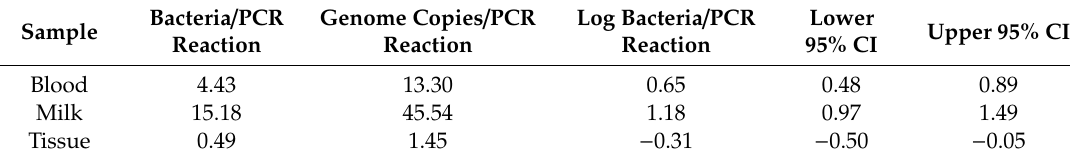
Table 5. Inter ‐ and intra ‐ assay reproducibility for the detection of Brucella spp., SD — standard deviation, C T— cycle threshold, CV — coefficient of variation.